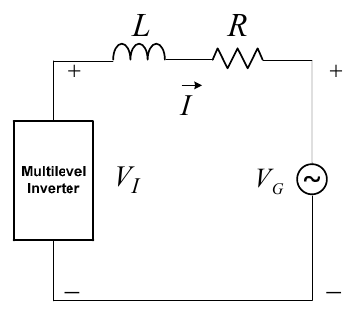
Figure 6. Single ‐ phase multilevel inverter connected to the single ‐ phase grid by a link inductor. Figure 6. Single-phase multilevel inverter connected to the single-phase grid by a link inductor.